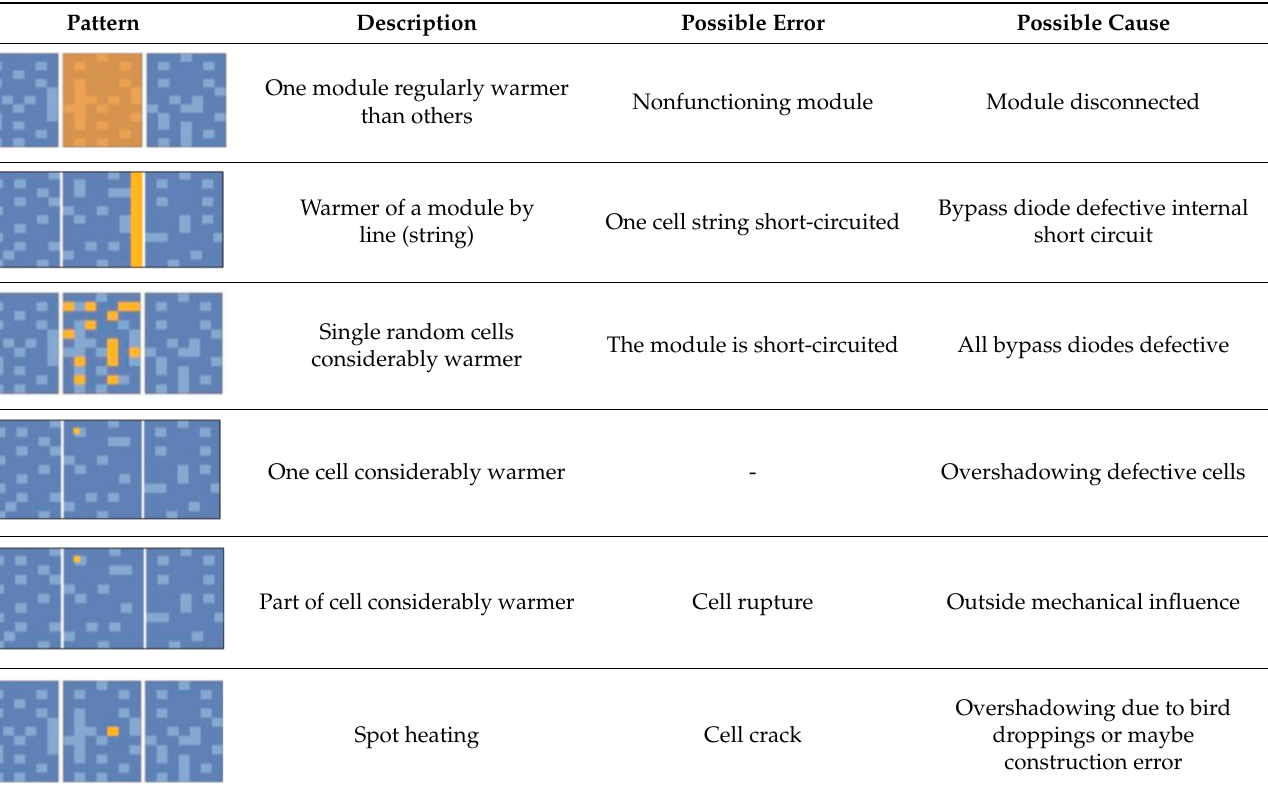
Table 1. Pattern of thermal image of defective panels.